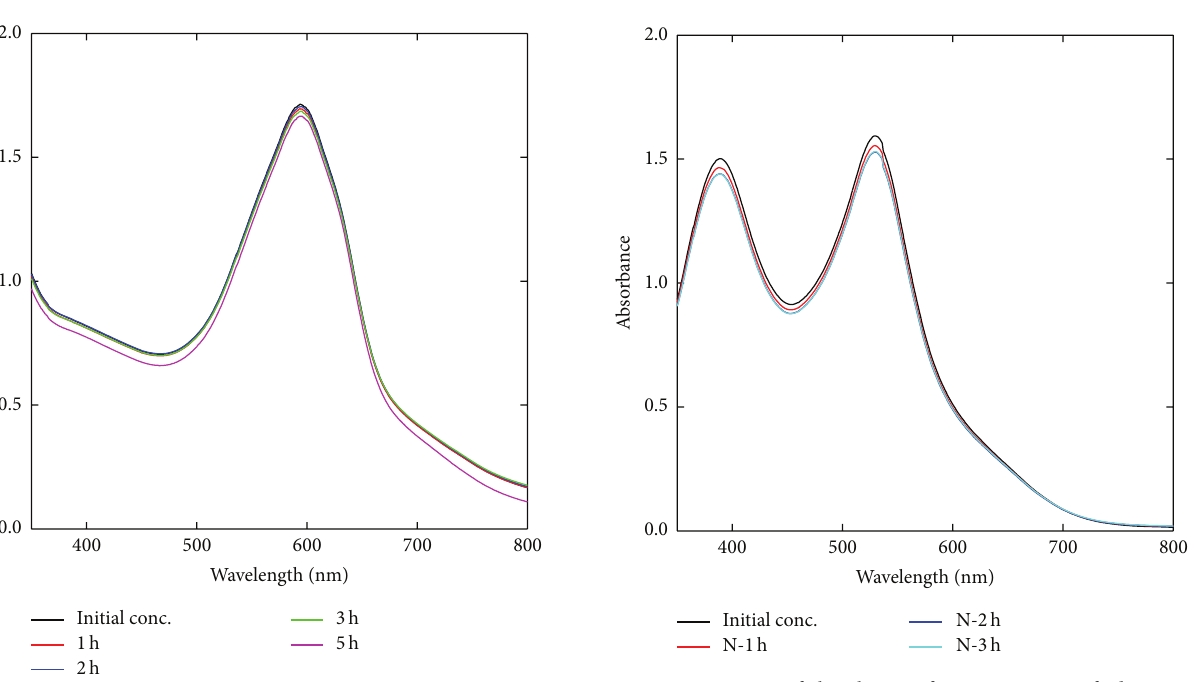
Figure 3: Variation of absorbance of Gardenia blue in terms of adsorption time on TiO 2 thin film.